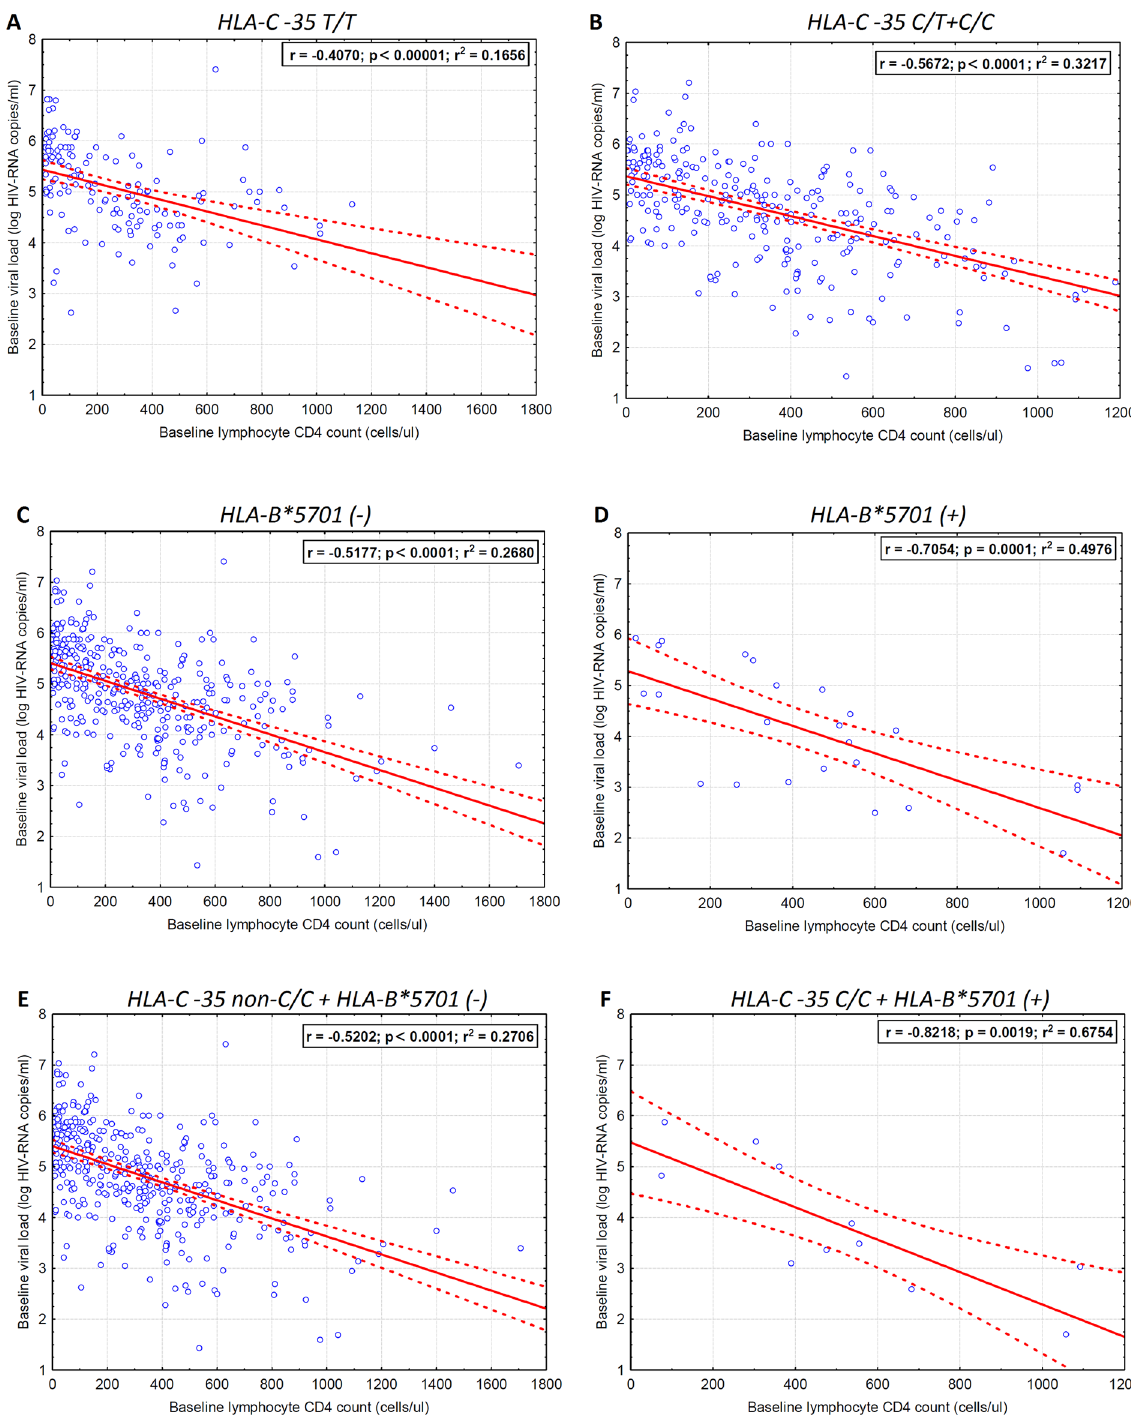
Fig 3. Linear regression curves for the pretreatment HIV-1 viral load data versus baseline lymphocyte CD 4 cell count for (a) HLA-C locus -35 T/T homozygotes, (b) HLA-C locus -35 C allele carriers (C/T+C/C), (c) HLA B * 5701 (-) genotype, (d) HLA B * 5701 (+) genotype, (e) compound HLA-C locus -35 non-C/HLA B * 5701 (-) and (f) HLA-C locus -35 C/C and HLA B * 5701(+) haplotype. Dotted line indicates 95 confidence interval for the logistic regression.